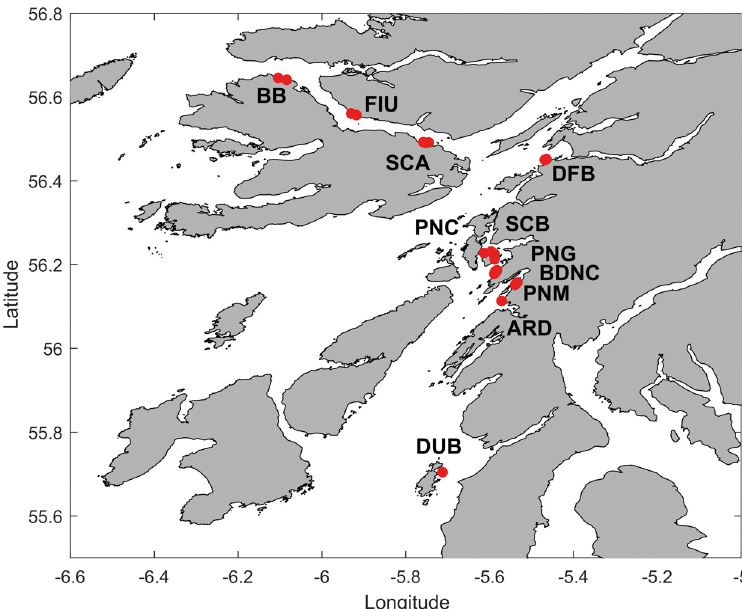
Fig. 1. Study sites, showing site codes (full names detailed in Table